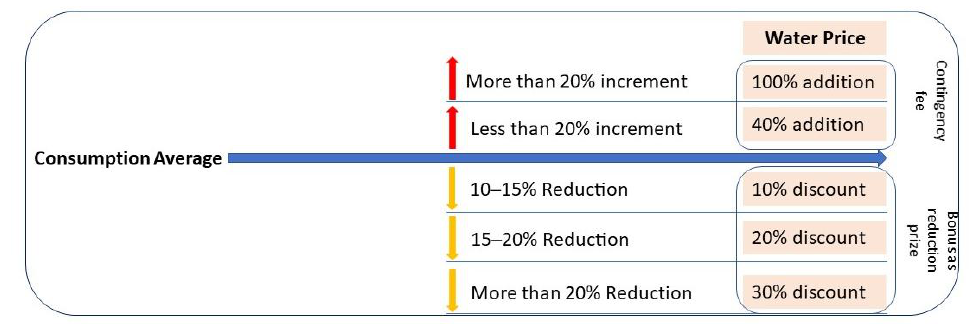
Figure 4. Companhia de Saneamento Básico do Estado de São Paulo S.A (SABESP) program to reduce overconsumption of water [49].